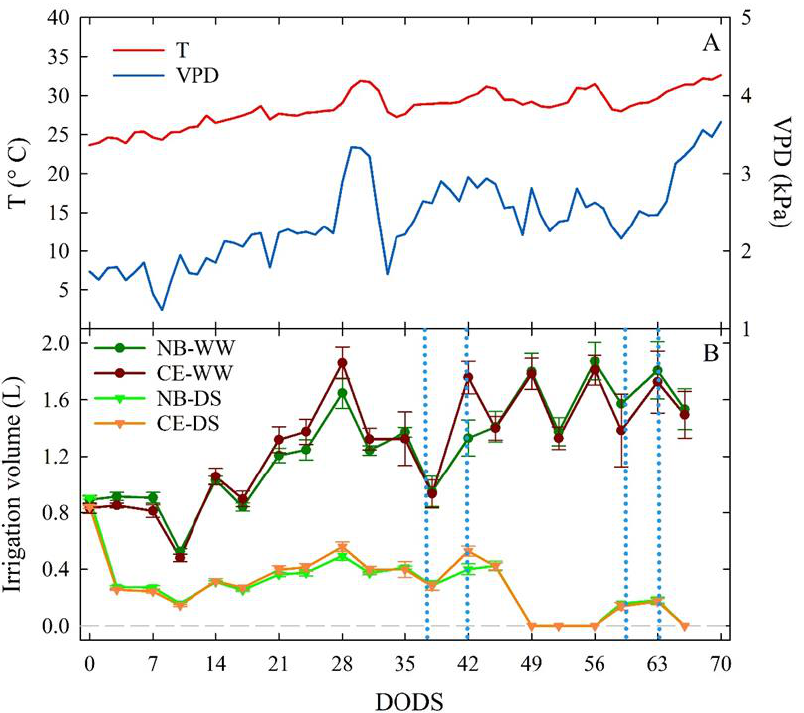
Figure 1. Daily trends of average temperature (T) and vapor pressure deficit (VPD) during the trial, expressed in days of drought stress (DODS) ( A ). Irrigation volumes supplied to well-watered and drought-stressed ‘Nocellara del Belice’ (NB-WW and NB-DS, respectively) and ‘Cerasuola’ (CE-WW and CE-DS, respectively) olive trees ( B ). Error bars in panel ( B ) indicate the standard errors of the